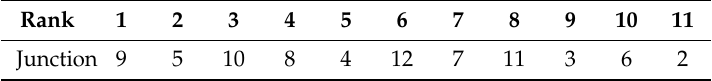
Table 5. Results of sensitivity analysis according to the change in demand.